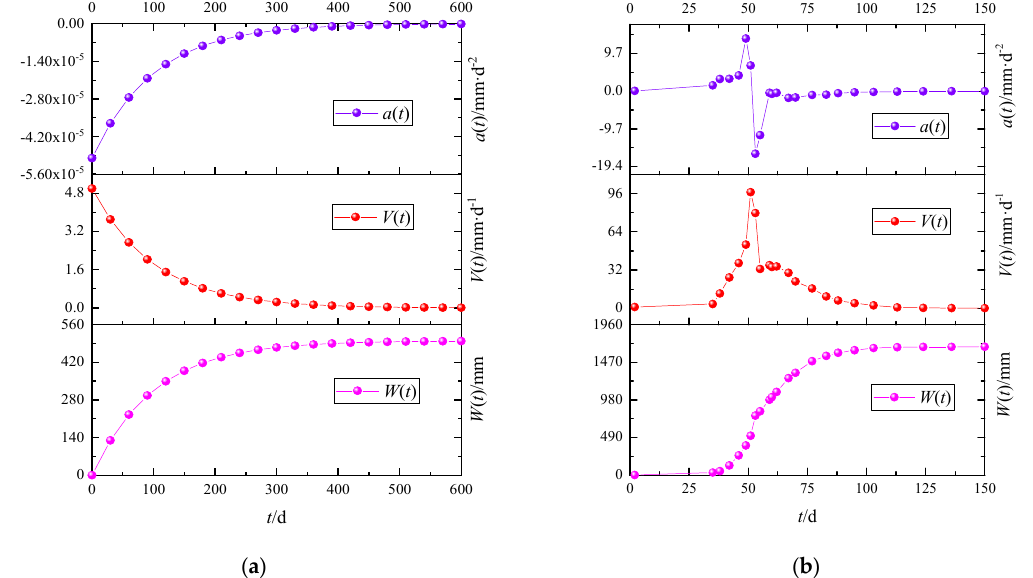
Figure 1. Surface point curve of subsidence, subsidence velocity, and subsidence acceleration: ( a ) based on Knothe time function model; ( b ) based on the field monitoring